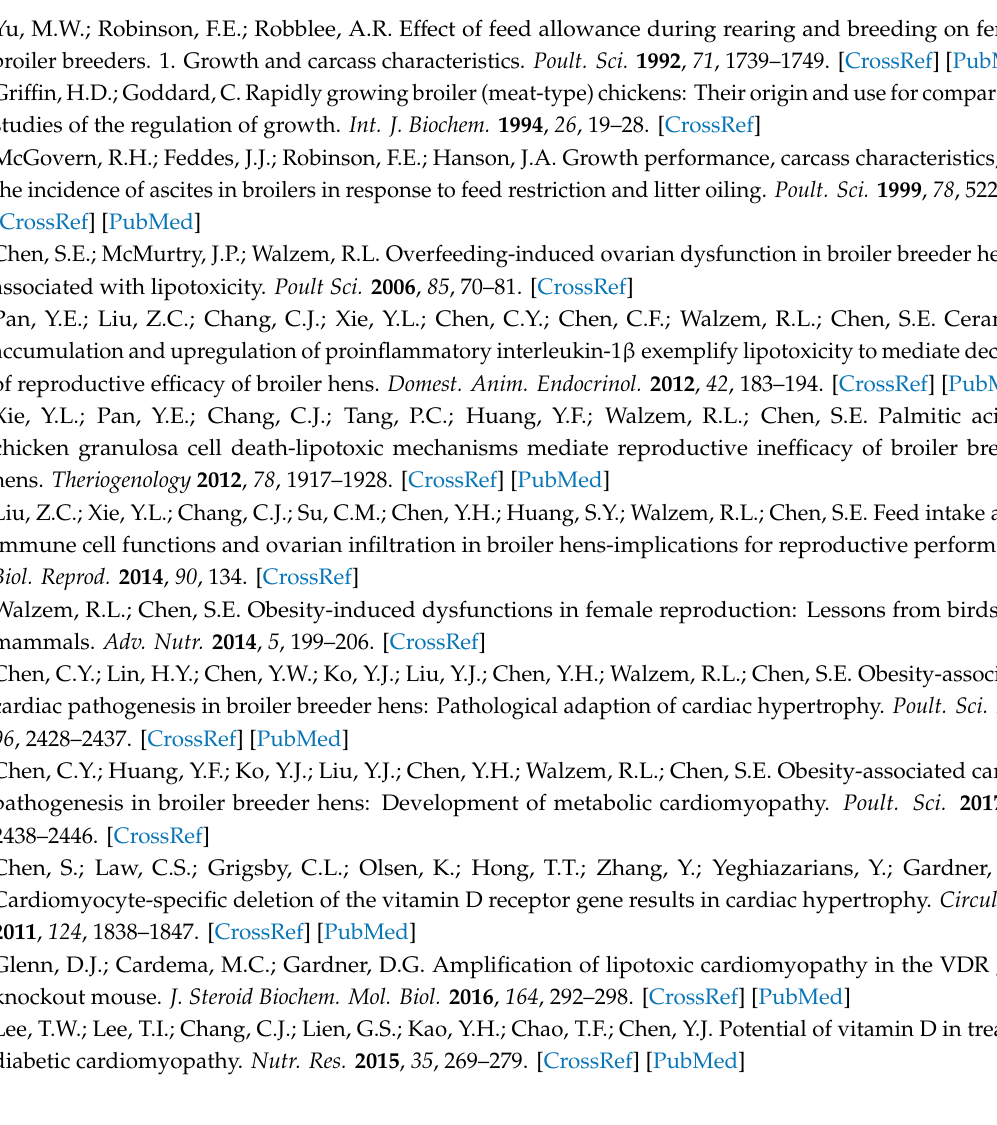
restricted or ad libitum feed intake, Table S1: E ff ect of dietary supplementation of 25-OH-D3 on the incidence of cardiac pathological morphology of broiler breeder hens provided with restricted or ad libitum feed intake, Table S2: E ff ect of dietary supplementation of 25-OH-D3 on the combination of cardiac pathological morphologies of broiler breeder hens provided with restricted or ad libitum feed intake, Table S3: E ff ect of dietary supplementation of 25-OH-D3 on the incidence of arrhythmic ECG patterns of broiler breeder hens provided with restricted or ad libitum feed